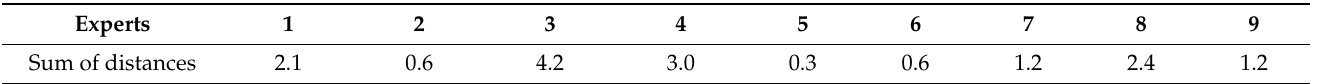
Table 4. Kemeny median between the opinion of one expert in relation to the others for the second parameter for 9 experts.